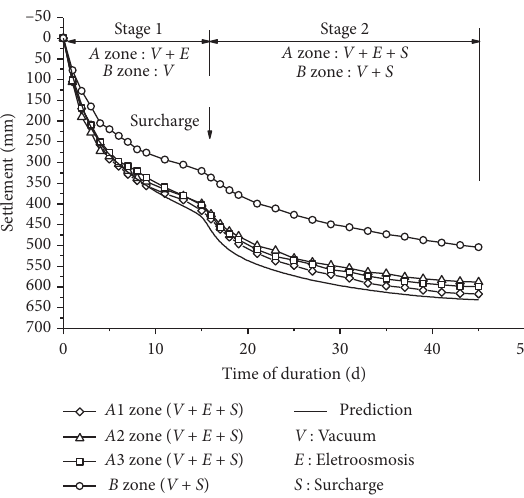
Figure 6: Surface settlements of test